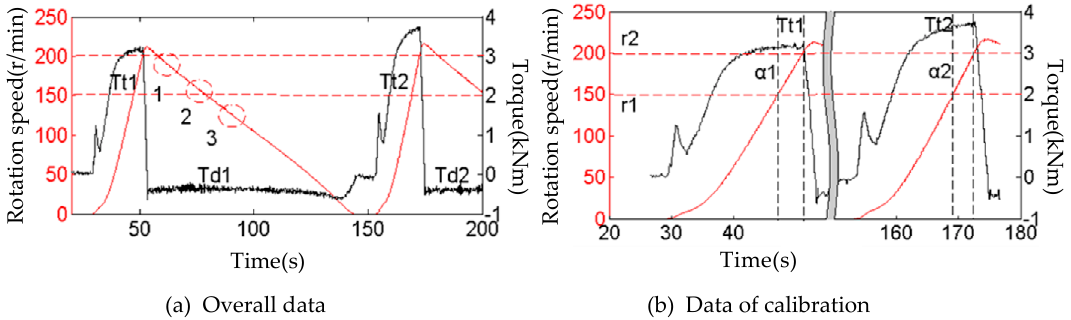
section Figure 16. Calibration test results under equivalent inertia of 2227.84 kgm 2 . Figure 16. Calibration test results under equivalent inertia of 2227.84 kg · m 2 .